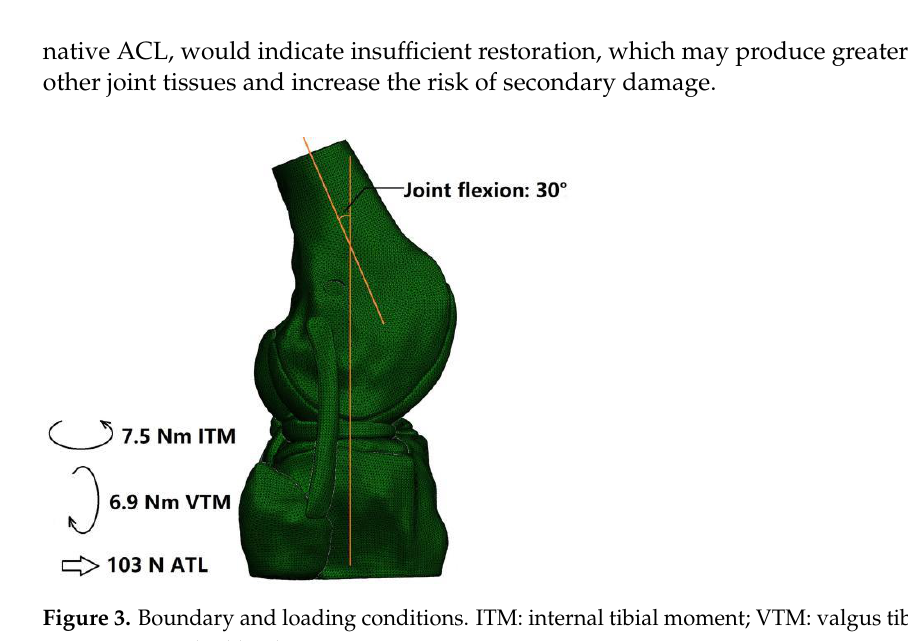
Table 2. Anterior tibial translation (ATT), internal tibial rotation (ITR), valgus tibial rotation (VTR) and ACL/graft force in the intact knee with a native-sized ACL and in the knee after anterior cruciate ligament reconstruction (ACLR) using different graft